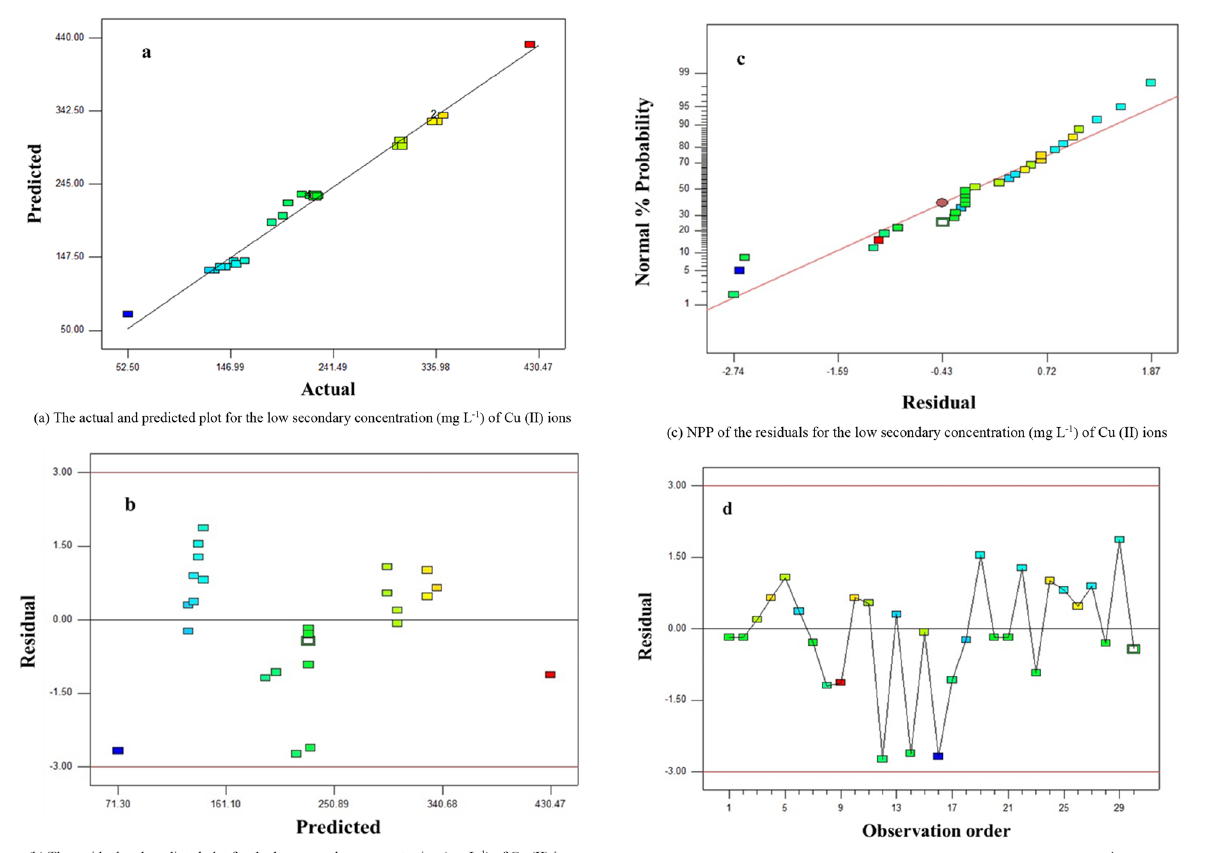
Figure 11. Residual graphs ( a ) the actual and predicted plot, ( b ) the residual and predicted plot, ( c ) normal probability plot ( d ) residuals vs. the order of the